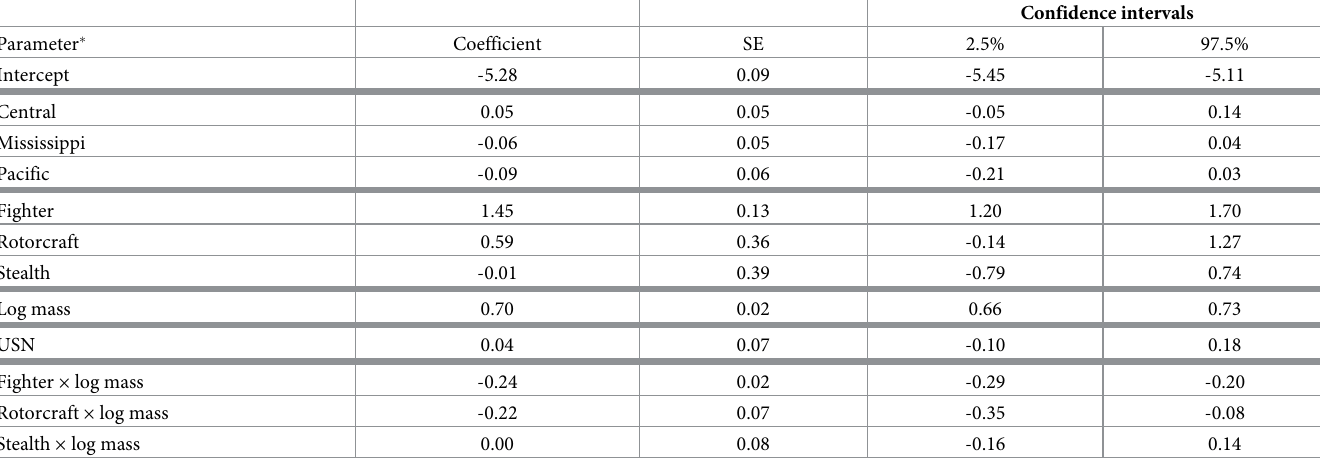
Table 3. Binary logistic regression models predicting any level of damage to Navy (USN) and Air Force (USAF) within the United States. This model represents the best as evaluated by the lowest Akaike’s Information Criterion (AIC) value (see S8 Table for other candidate models). McFadden’s r 2 value is 0.12. Predictor variables include migration flyway (Central, Mississippi, Pacific, Atlantic), airframe (cargo, rotorcraft, stealth, fighter), avian log body mass, military branch (USN or USAF), and the airframe × avian log body mass interaction.